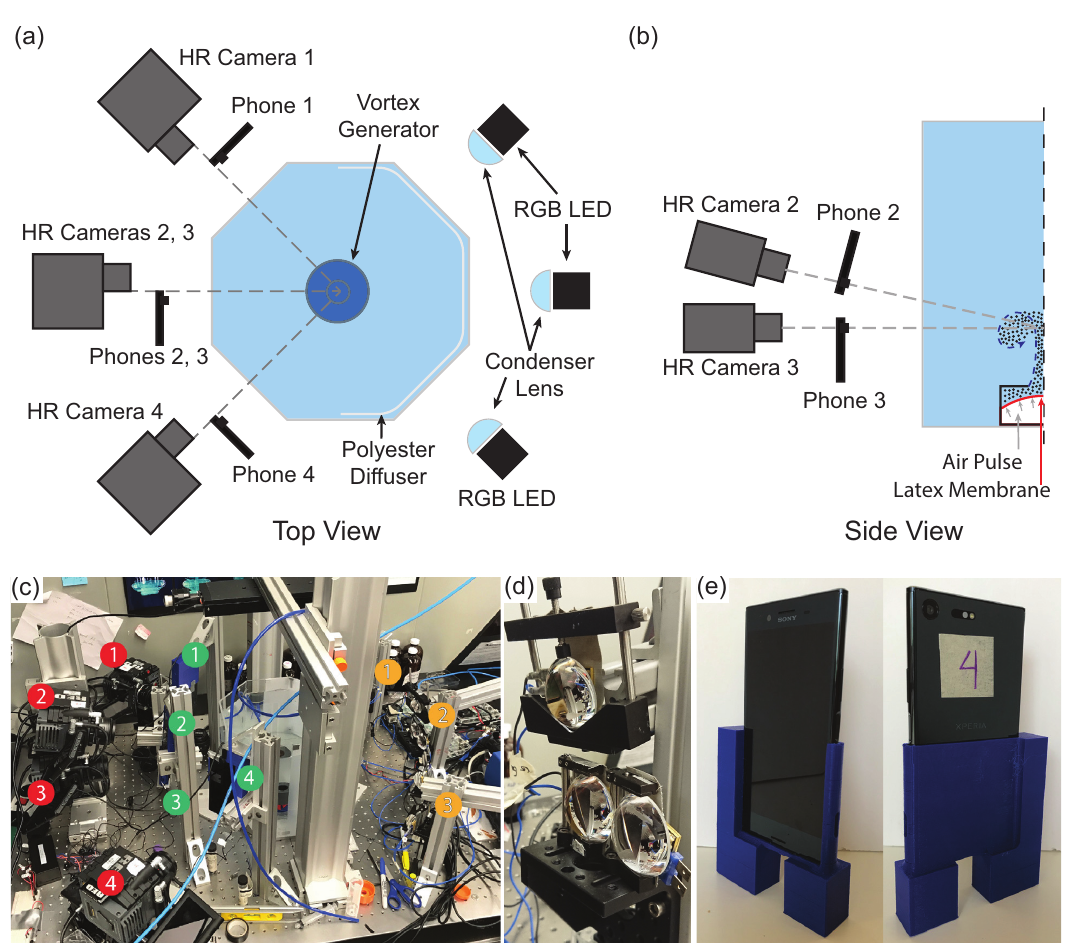
Figure 1. ( a ) Top view sketch of the experimental setup showing the positioning of smartphones, high-resolution (HR) cameras, and LED back-lighting around an octagonal tank. ( b ) Side-view sketch showing the vertical positioning of the central cameras and a cross-section of the vortex generator at the tank centerline. ( c ) Photograph of experimental setup. HR Red Cinema cameras are labeled with red circles, while the Xperia smartphones are labeled with green circles and the LED clusters are labeled with orange circles. ( d ) Close-up detailed photograph of an RGB LED cluster with lenses. ( e ) Detail photographs of the custom, in-house 3D printed smartphone holder to stiffly mount the smartphones via aluminum struts to the optical